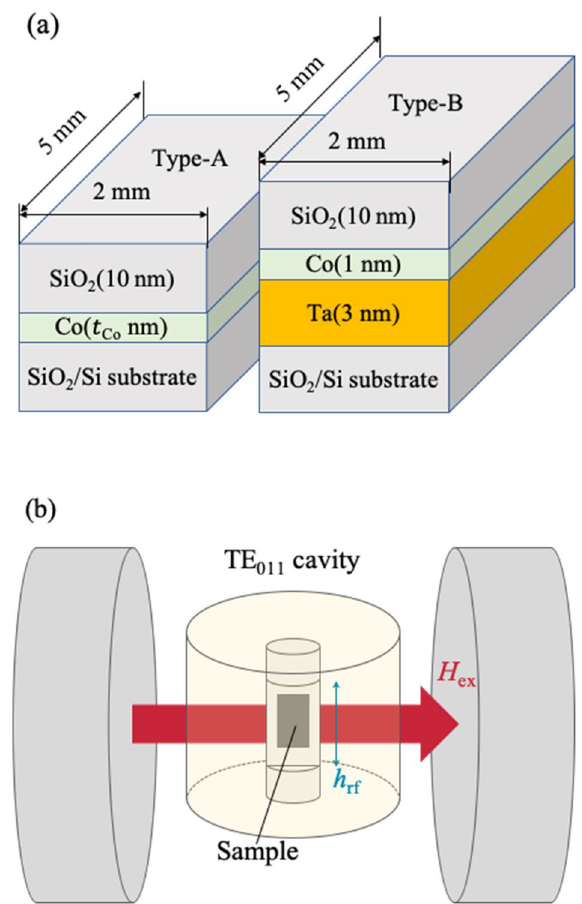
Figure 1. ( a ) Schematics of the sample structures of the type-A and the type-B samples. The thickness of the Co ( t Co ) in the type-A samples was 1, 2, 3, or 5 nm. The samples were capped with 10 nm-thick SiO 2 to prevent oxidization of the Co. ( b ) Schematic of the setup used for FMR